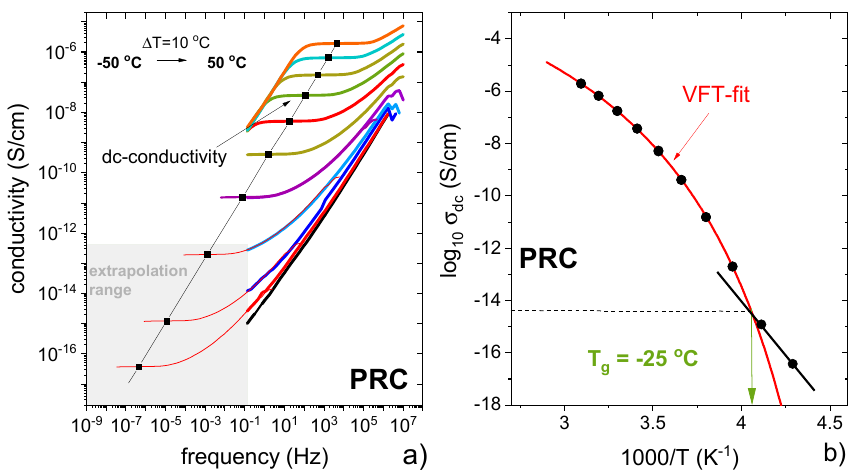
Figure 9. ( a ) Dielectric data of PRC presented in conductivity representation. ( b ) Temperature dependence of dc-conductivity of PRC.